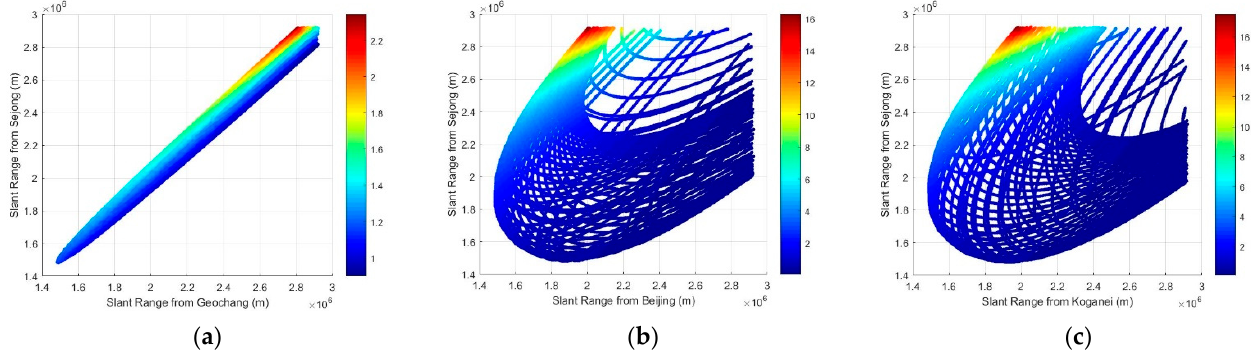
Figure 4. Ratio of geometric effects including free space loss and atmospheric transmission in TLTT link budget with respect to ordinary SLR observation. ( a ) Sejong − Geochang, ( b ) Sejong − Beijing and ( c ) Sejong − Koganei.